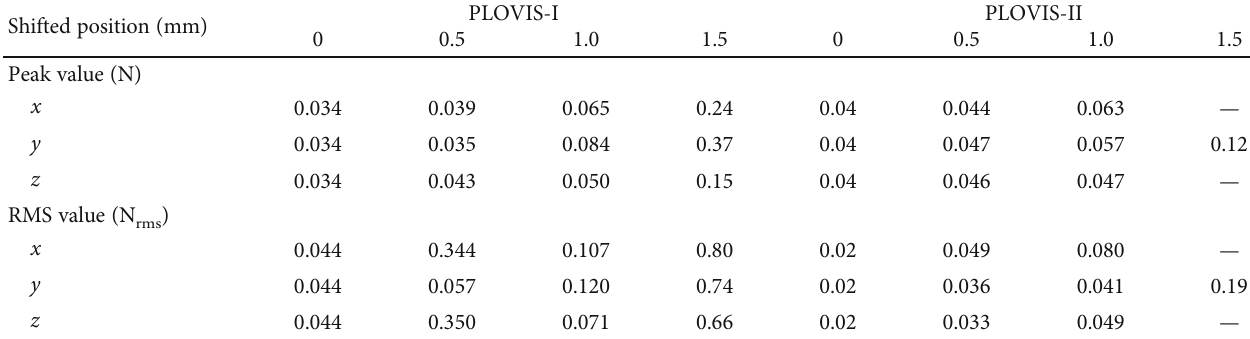
Table 7: Summary of position sensitivity test